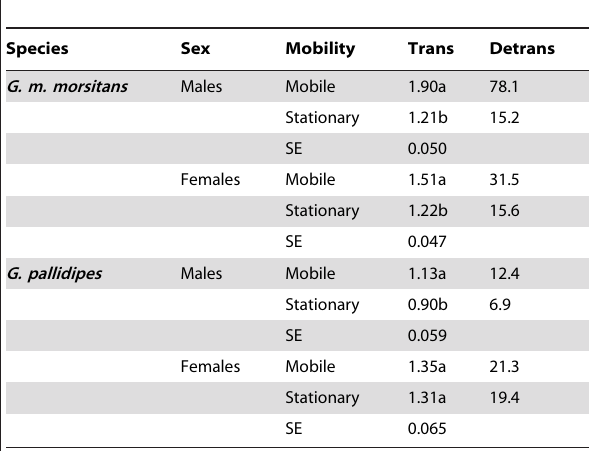
Table 5. Catches of tsetse from a mobile or stationary ox accompanied by men.